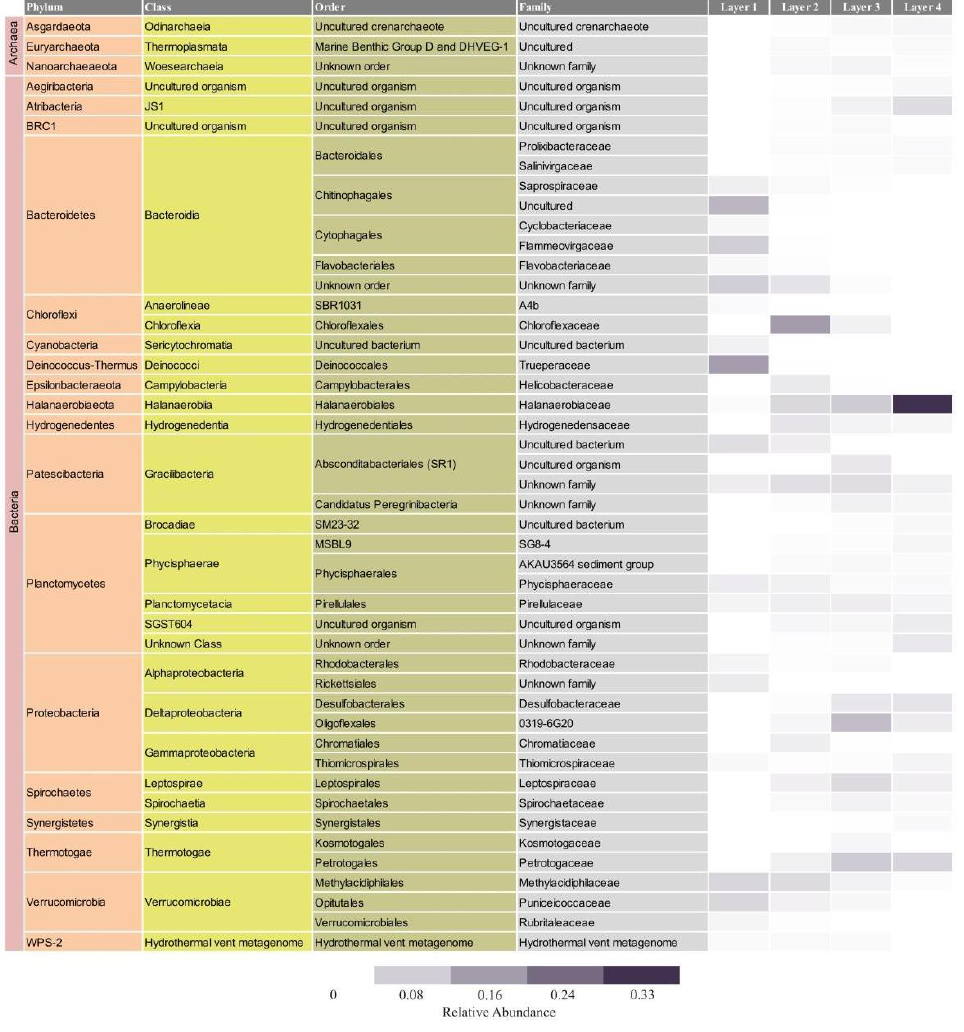
Figure 6. Relative abundance and taxonomic assignment of the main families found in each layer.